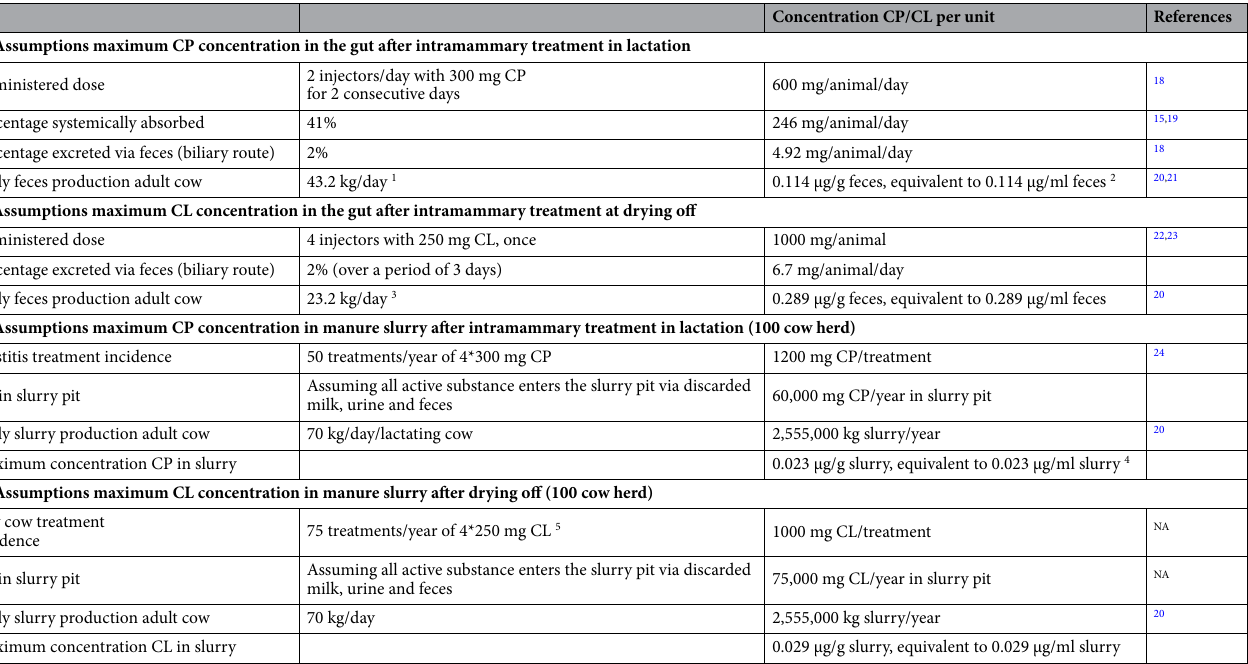
Table 1. Assumed maximum concentration of CP, in the bovine gut after intramammary treatment (IMM) during lactation (A), of CL in the bovine gut after IMM at drying off (B), of CP in manure slurry after IMM during lactation in a 100 cow dairy herd (C), and of CL in manure slurry after IMM at drying off in a 100 cow dairy herd (D). 1 Daily manure production lactating cow 66.3 kg minus 23.1 kg urine production 21 . Low estimation of fecal production per cow per day as found in the literature. 2 Assumption density of